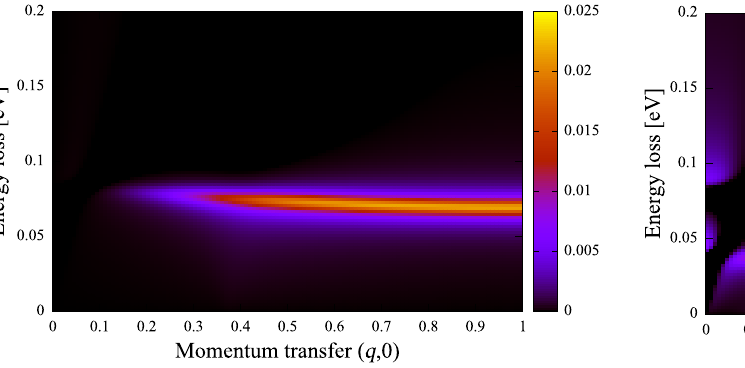
.FIG. 7. Cu-O bond-stretching (breathing) phonon contribution to RIXS. Momentum transfer is given in units of π =a .